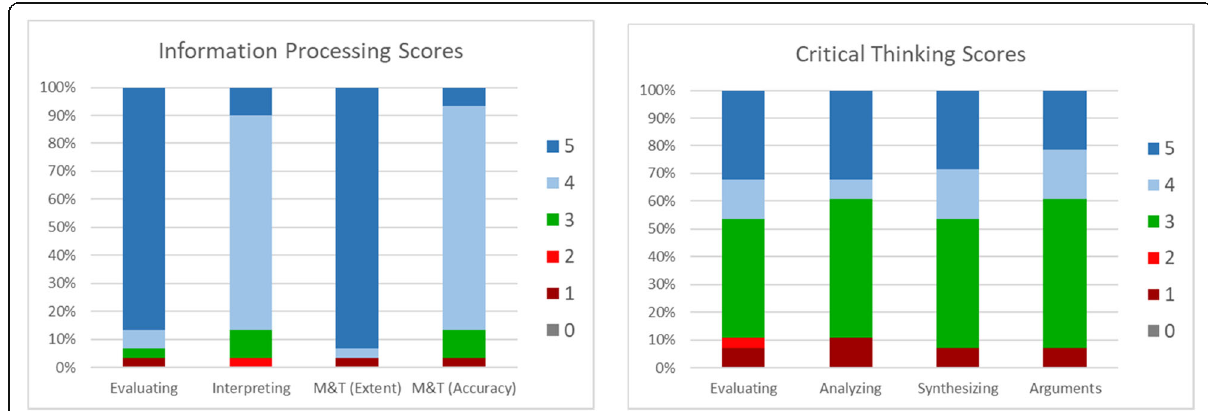
Fig. 3 Student rubric scores from an organic chemistry laboratory course. The two rubrics were used to evaluate different laboratory reports. Thirty students were assessed for information processing and 28 were assessed for critical